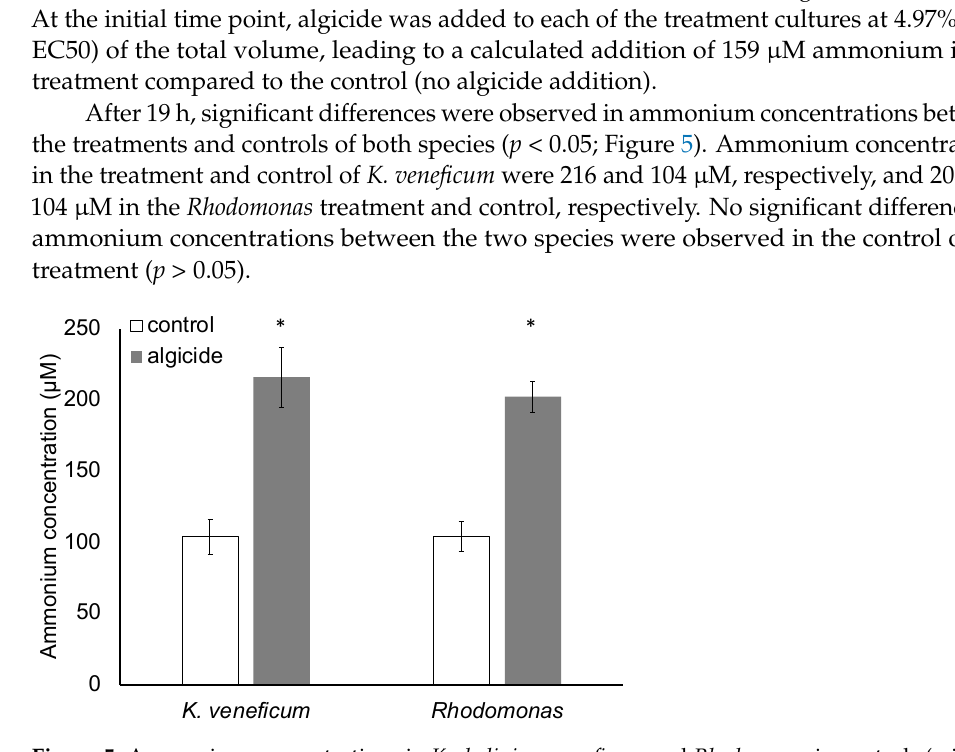
Figure 5. Ammonium concentrations in Karlodinium veneficum and Rhodomonas in controls (with no algicide addition) and the algicide treatment measured after 19 h incubation. Error bars indicate standard deviations of 3 replicates. Asterisks indicate a significant difference of ammonium concen- trations in the indicated treatment compared to the control ( p < 0.05).